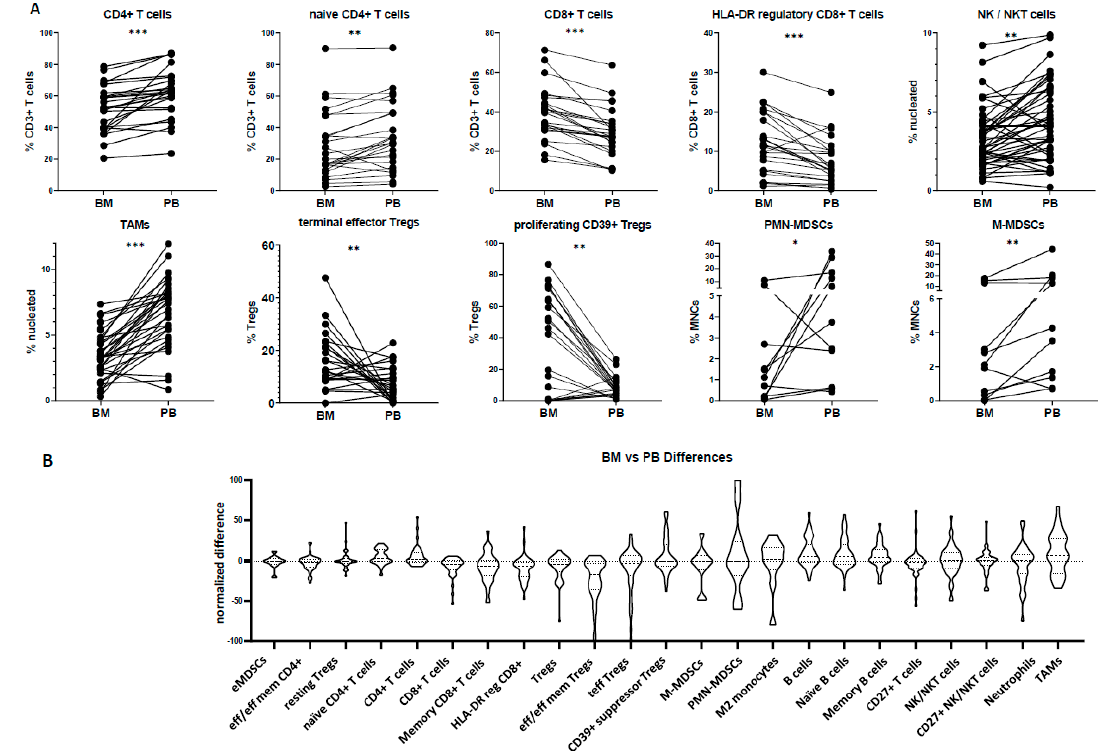
Figure 2. ( A ) Pairwise comparison of subset distributions between the bone marrow (BM) and peripheral blood (PB); ( B ) differences plot displaying the pairwise differences (PB minus BM) of normalized expression measures for all immune subsets. Subsets that tend to mirror between PB and BM appear on the left side of the plot. * p < 0.05; ** p < 0.01; *** p < 0.001.